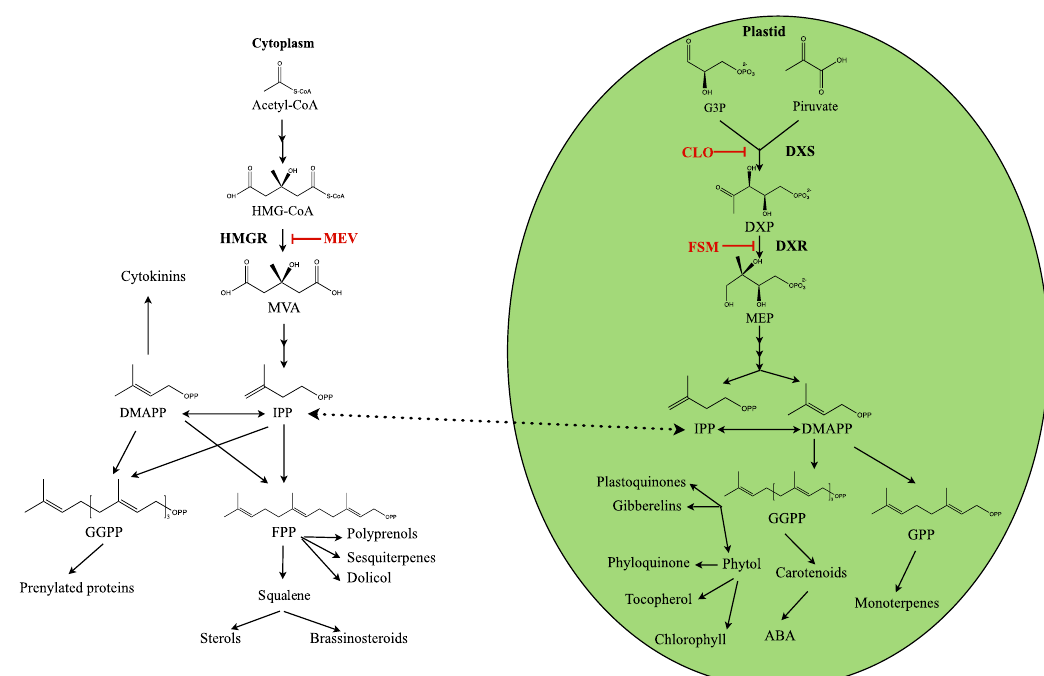
Figure 1. General scheme of the terpene synthesis pathways in plants and their inhibitors. ABA: abscisic acid. CLO: clomazone. DMAPP: isomer dimethylallyl diphosphte. DXP: 1-deoxy- D -xylulose 5-phosphate. DXR: DXP reductoisomerase. DXS: DXP synthase. FPP: farnesyl diphosphate. FSM: fosmidomycin. GGPP: geranylgeranyl diphosphate. G3P: D -glyceraldehyde-3 phosphate. HMG-CoA: 3-hydroxy-3-methylglutaryl-coenzyme A. HMGR: HMG-CoA reductase. IPP: isopentenyl diphosphate. MEP: methyl- D -erytritol-4-phosphate. MEV: mevinoline. MVA: mevalonate [10,11]